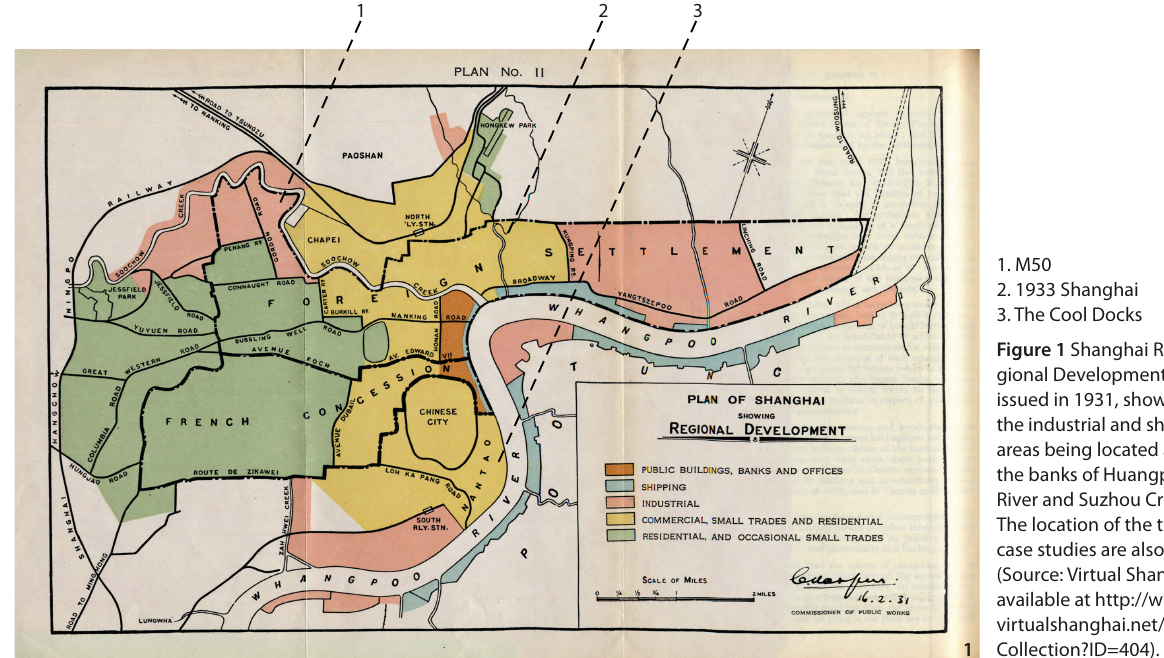
Figure 1 Shanghai Re- gional Development Plan issued in 1931, showing the industrial and shipping areas being located along the banks of Huangpu River and Suzhou Creek. The location of the three case studies are also noted (Source: Virtual Shanghai, available at http://www. virtualshanghai.net/Maps/ Collection?ID=404).